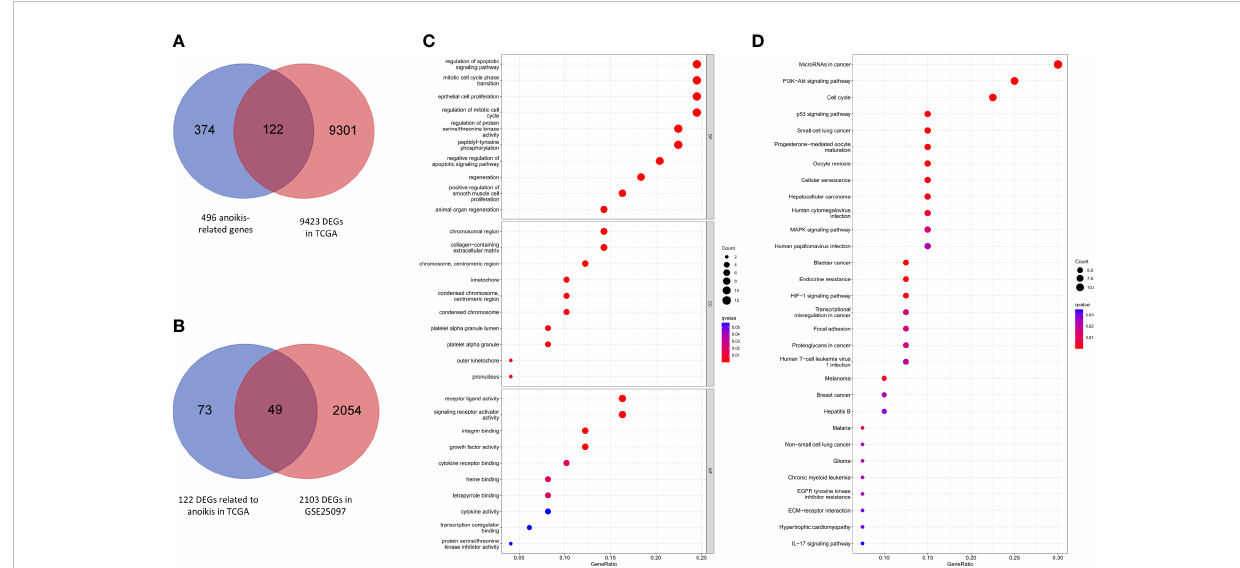
FIGURE 2 Anoikis-related gene screening and functional analysis. (A) Anoikis-related DEGs in TCGA. (B) Further validation in GSE25097. (C) GO enrichment analysis of 49 anoikis-related DEGs in HCC. (D) KEGG pathways analysis of 49 anoikis-related DEGs in